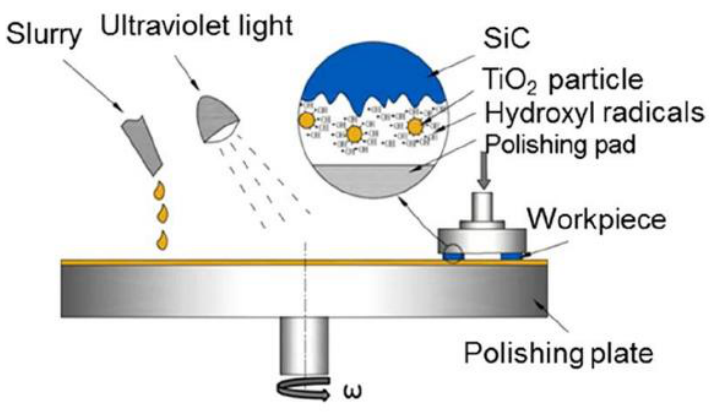
Figure 10. Schematic of the PCMP setup [14].